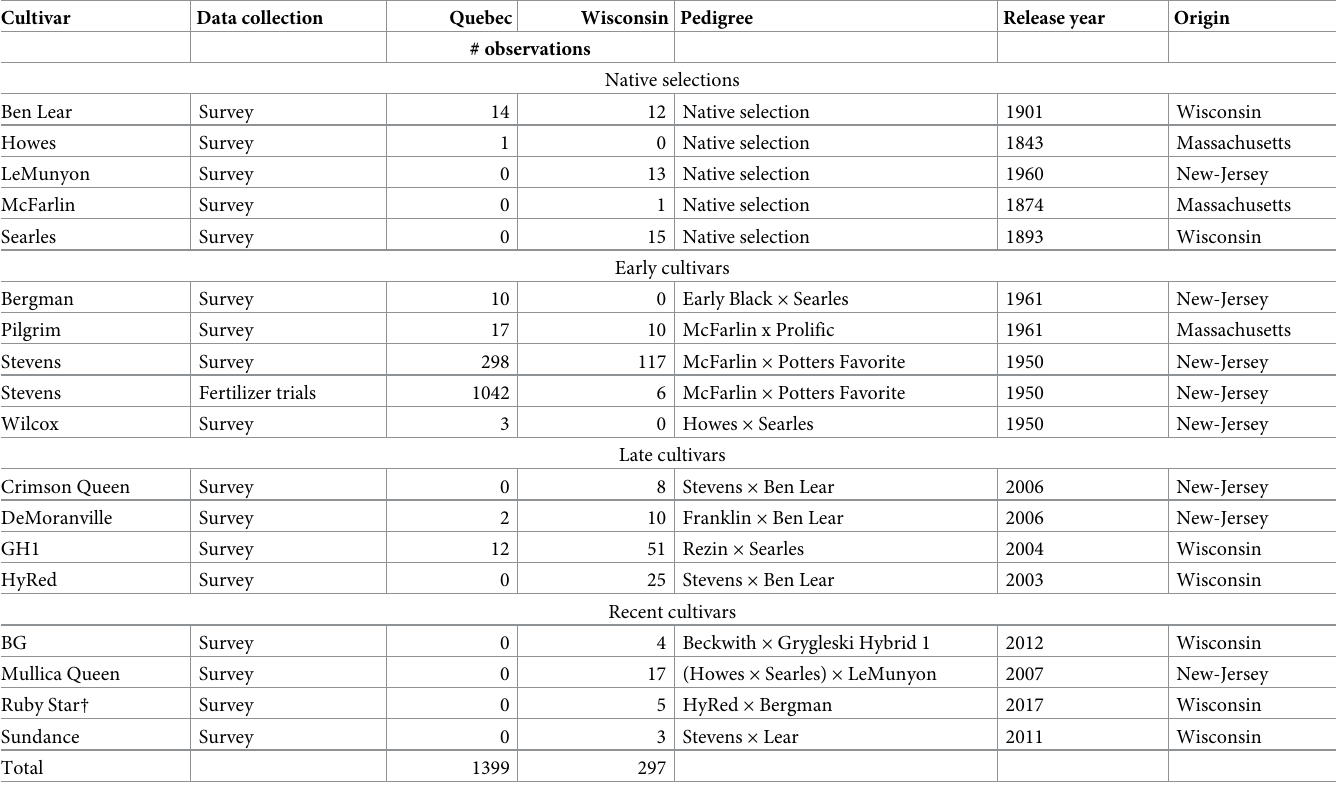
Table 1. Regional provenance and pedigree [6,36]of cranberry cultivars in the dataset.